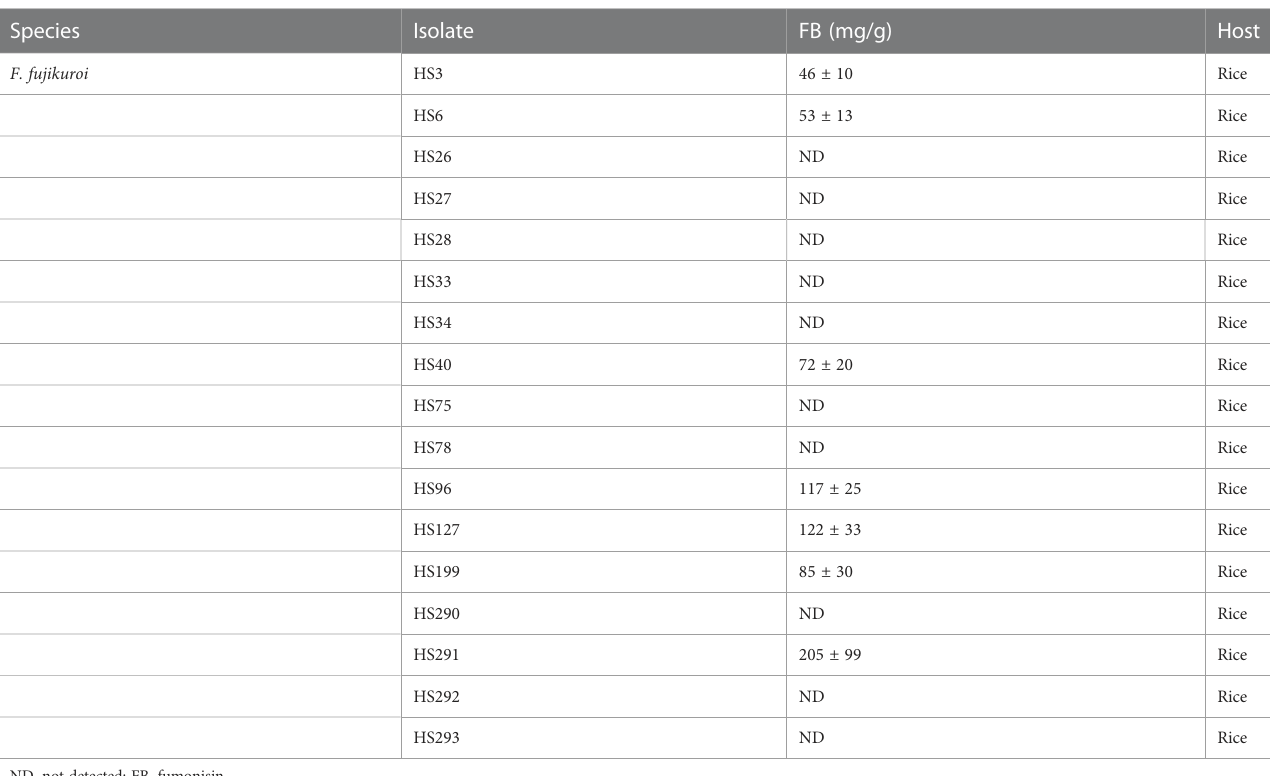
ND, not detected; FB,